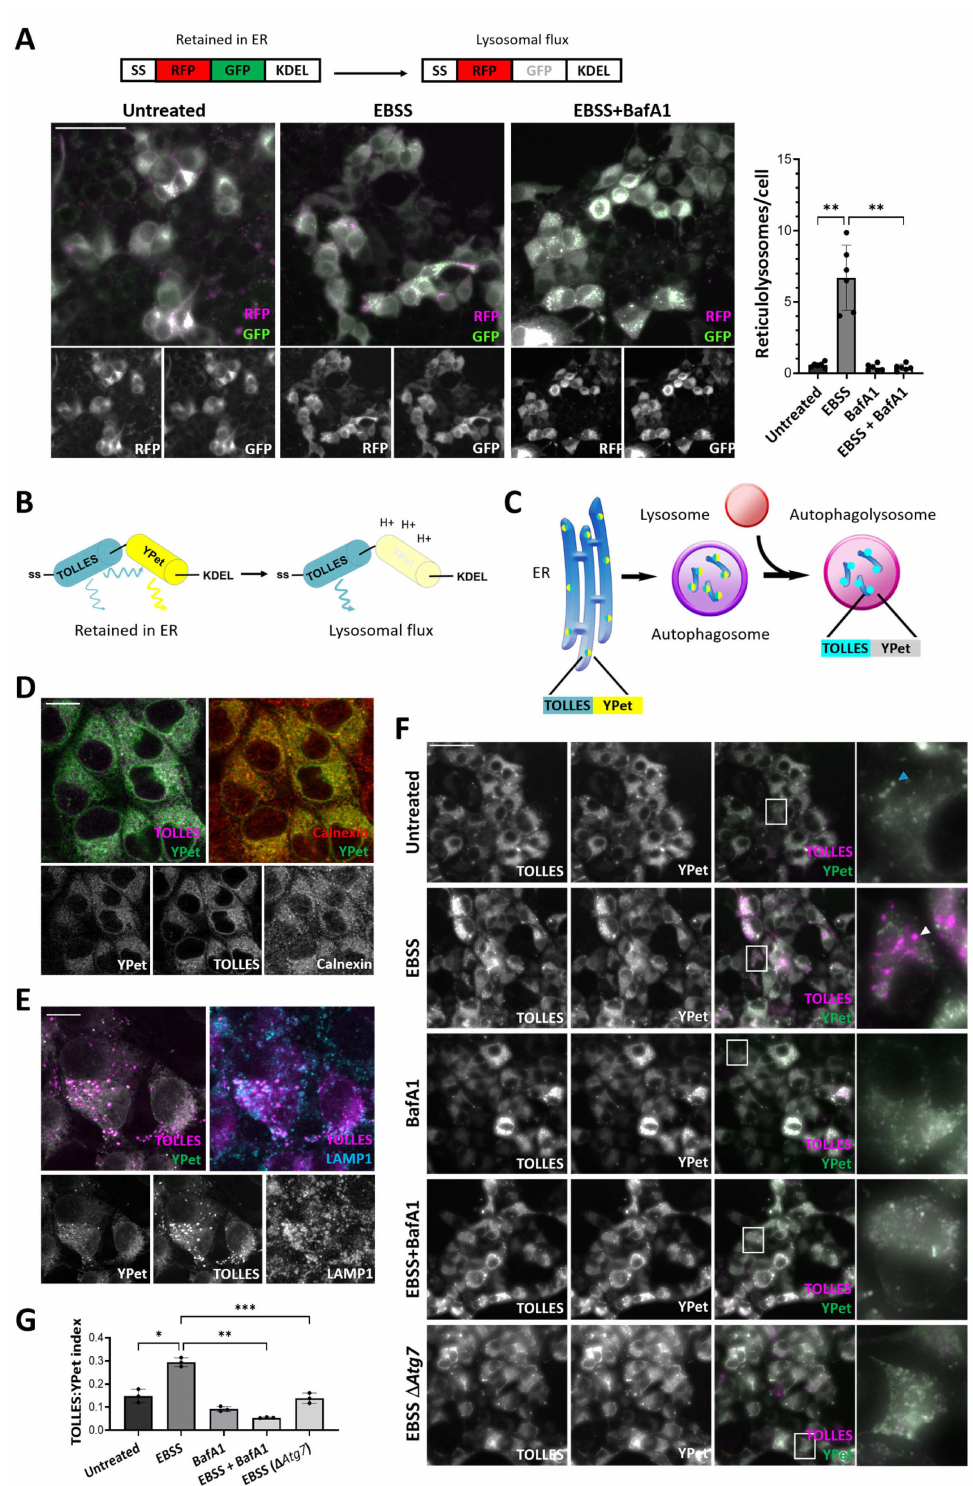
Figure 3. Development of ss-SRAI-KDEL for reliable measurement of general ER-phagy. ( A ) Schematic of the expected fluorescence profile of the ER-phagy reporter ss-RFP-GFP-KDEL within different compartments, where GFP is quenched in the lysosomes. RFP is represented in red and GFP in green or white if quenched. ss, signal sequence. Imaging-based autophagic flux assay in ss-mRFP-GFP-KDEL PDAC cells in full nutrients (untreated) or following 4 h starvation in the presence or absence of BafA1 (50 nM) and imaged using automated widefield microscopy. Cells